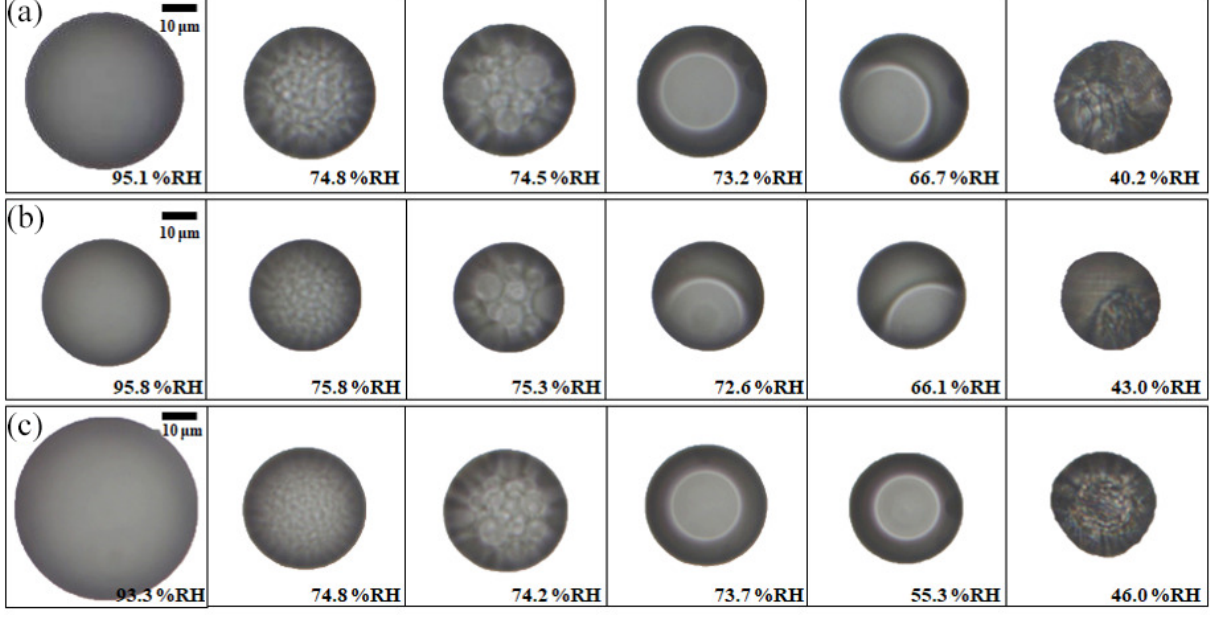
Figure 2. Image sequences of liquid–liquid phase separation and efflorescence leading to (a) the morphological transition from core–shell to partially engulfed, (b) partially engulfed morphology and (c) core–shell morphology of 3-MGA/AS droplets (OIR = 1) at 290 ± 1K upon dehumidification at a rate of 0.2%–0.3% RHmin − 1 . The size bar in the figure corresponds to